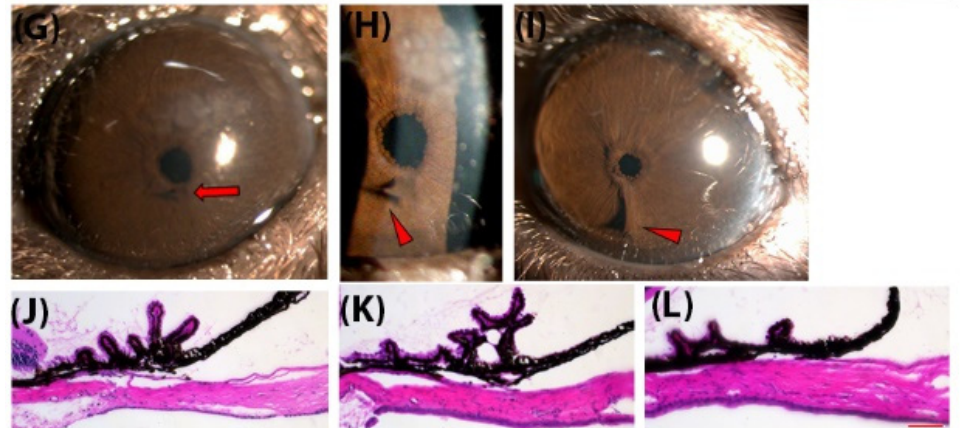
Figure 1. Anterior segment morphology in egl1 mice. ( A – I ) Representative slit lamp image from C57BL/6J ( A ) and egl1 mice ( B – I ). ( A ) Representative slit lamp image showing clear and avascular cornea and centrally located pupil in uniformly shaped iris. ( B ) Normal cornea from an egl1 mouse. ( C – I ) Anterior segment lesions in egl1 mice. The egl1 mice developed a variety of anterior segment lesions (indicated by triangles) such as localized faint opacity in paracentral zone of the cornea ( C ), dense corneal opacity with neovascularization ( D , E ), iris thinning ( D , E ) and pupil deviation ( E ), diffuse opacity covering the entire cornea ( F ), and iris synechiae (the iris adhesion to the cornea) ( G – I ). ( H ) Enlarged view of area indicated by arrow in ( G ). ( J – L ) Representative H&E staining images of cross-section of the ciliary body and iridocorneal angle from C57BL/6J ( J ), egl1 mouse with normal IOP ( K ) and after 4 weeks of IOP elevation ( L ). The iridocorneal angle remained open and ciliary body appeared normal triangular in C57BL/6J and the egl1 mice with normal IOP. Anterior synechiae (the iris attached in the iridocorneal angle) and ciliary body atrophy were seen in eyes with elevated IOP. Scale bar = 50 µm.